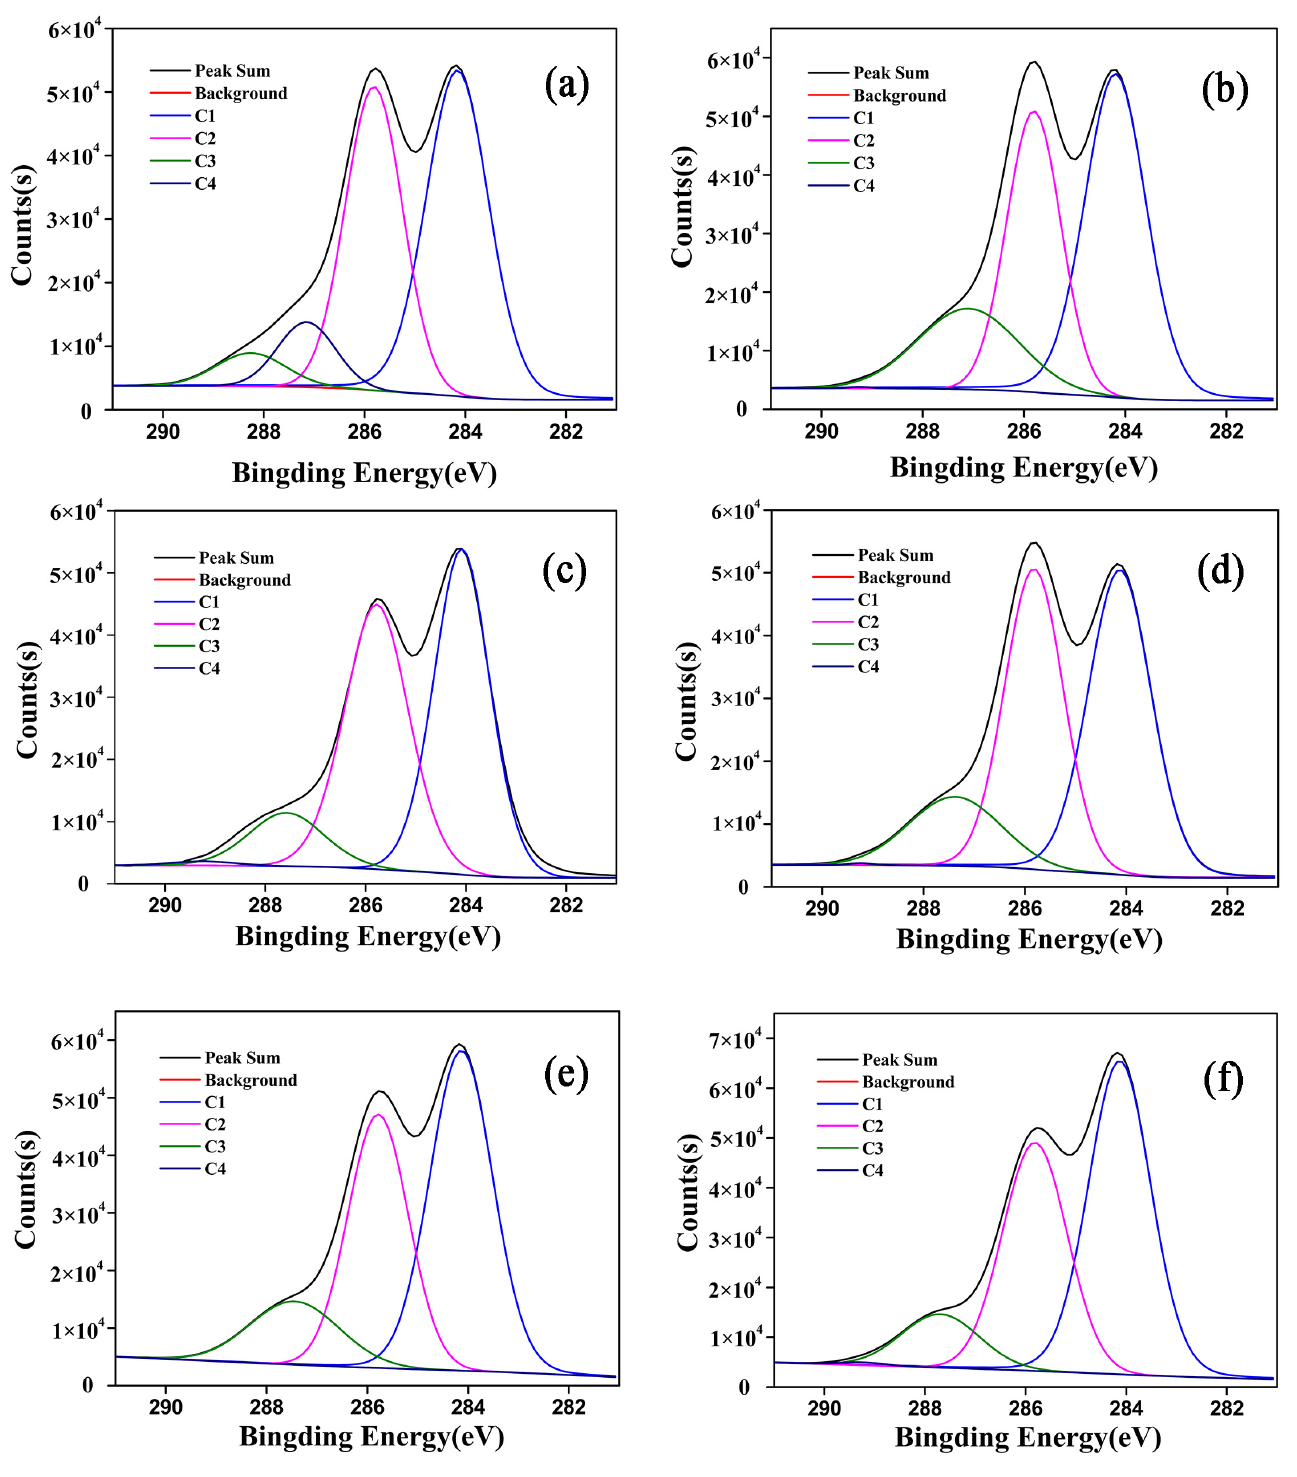
Figure 5. C1s XPS spectra of untreated and vacuum heat-treated bamboo fiber surface, wherein ( a – f ) are C1s XPS spectra of untreated, 140 ◦ C, 160 ◦ C, 180 ◦ C, 200 ◦ C and 220 ◦ C,